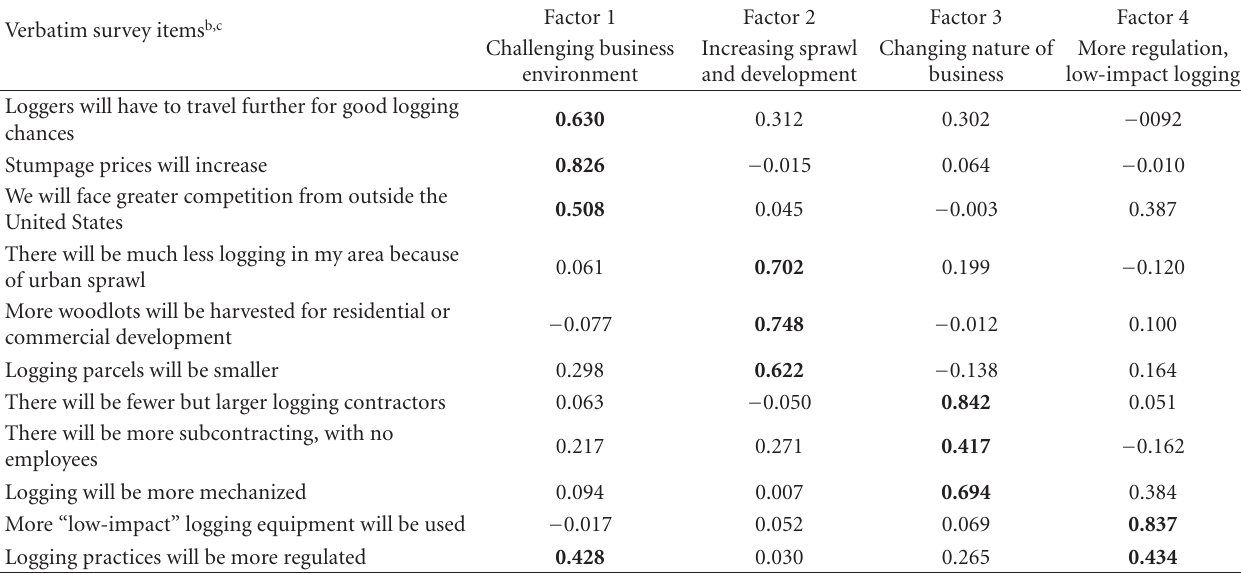
Table 1: Rotated component matrix with factor loadings for Logging Industry Outlook Attitude Scale a . Bold indicates factor loadings over 0.40, contributing most to latent theme of the subscale.